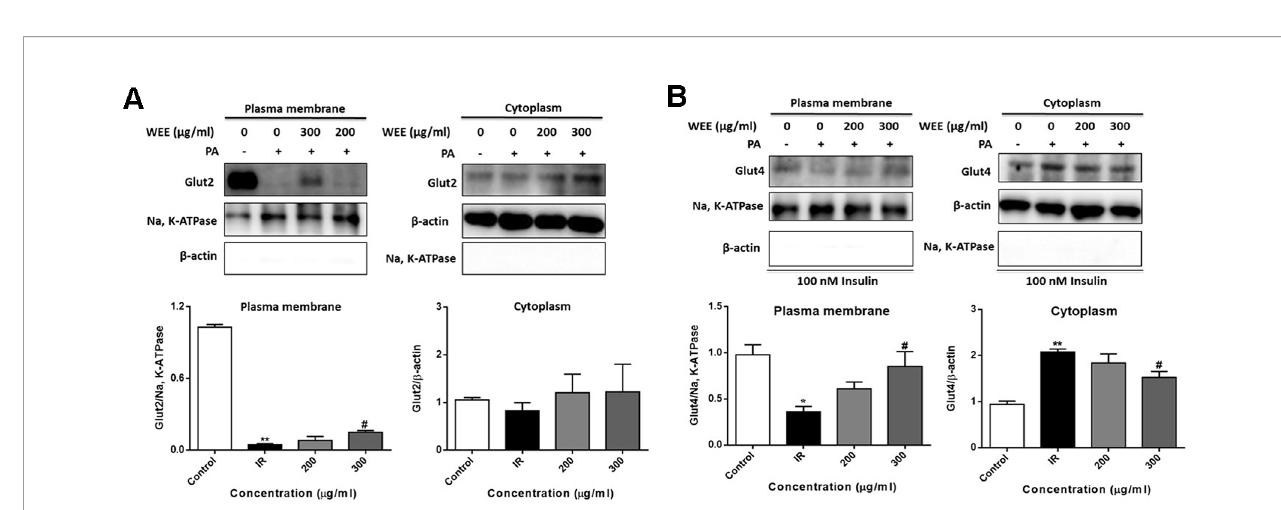
FIGURE 9 | WEE promoted the translocation of GLUT2 and GLUT4 in PA treated HepG2 cells. HepG2 cells were incubated with normal glucose (5.5 mM) or high glucose (30 mM) and PA (0.3 mM) in the absence or presence of WEE (200 and 300 m g/ml) for 24 h. The expression levels of GLUT2 in the plasma membrane and cytoplasm fraction were determined by Western blotting (A) . After 24 h treatment and followed by exposure to insulin (100 nM) for 30 min. The expression levels of GLUT4 in plasma membrane and cytoplasm fraction were determined by Western blotting (B) . The bar graphs represent the relative expression of GLUT2 and GLUT4 in the plasma membrane and cytoplasm fraction. Data presented in bar charts are mean ± SEM values from six independent experiments. Groups are signi fi cantly different from the control group at *p < 0.05, **p < 0.01. The groups are signi fi cantly different from the IR group at # p < 0.05 determined by Dunnett ’ s multiple comparisons